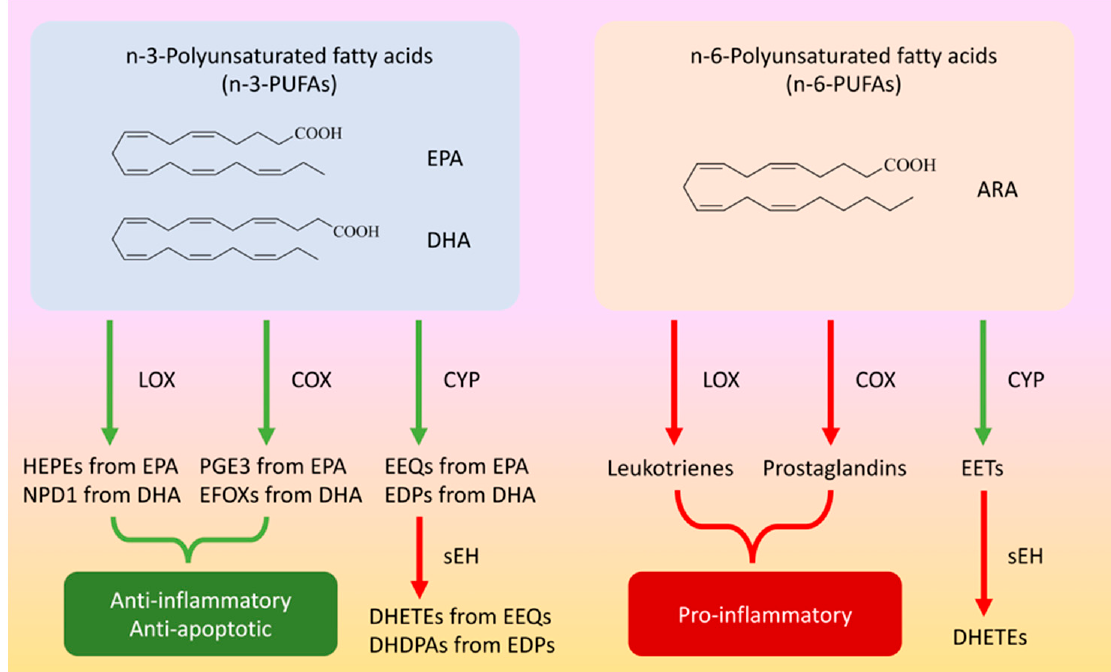
Figure 1. Metabolism of eicosapentaenoic acid (EPA), docosohexaenoic acid (DHA), and arachidonic acid (ARA). Eicosapentaenoic acid (EPA) is converted into hydroxyeicosapentaenoic acids (HEPEs) and prostaglandin E3 (PGE3) through the lipoxygenase (LOX) and cyclooxygenase (COX) pathways, respectively. Docosohexaenoic acid (DHA) is also converted into neuroprotectin D1 (NPD1) and elec- trophile oxo-derivatives (EFOXs) through the LOX and COX pathways, respectively. The compounds HEPEs, NPD1, PGE3, and EFOXs act as anti-inflammatory and anti-apoptotic mediators, while EPA and DHA are converted into epoxyeicosatetraenoic acids (EEQs) and epoxydocosapentaenoic acids (EDPs) through the cytochrome P450 (CYP) pathway, respectively. Moreover, these epoxide fatty acids are metabolized into their corresponding diols (DHETEs and DHDPAs) by soluble epoxide hydrolase (sEH), while arachidonic acid (ARA) is converted into leukotrienes and prostaglandins by the LOX and COX pathways, respectively. Finally, ARA is converted into epoxyeicosatrienoic acids (EETs) by the CYP pathway, and these EETs are metabolized into their corresponding diols (DHETs) by sEH. In this case, epoxy fatty acids (EEQs, EDPs, and EETs) have anti-inflammatory effects. Specifically, PUFAs are metabolized into bioactive derivatives by main enzymes such as cyclooxygenases (COXs), lipoxygenases (LOXs), and cytochrome P450s (CYPs) (see Figure 1) [26–28], whereas EPA is converted into hydroxyeicosapentaenoic